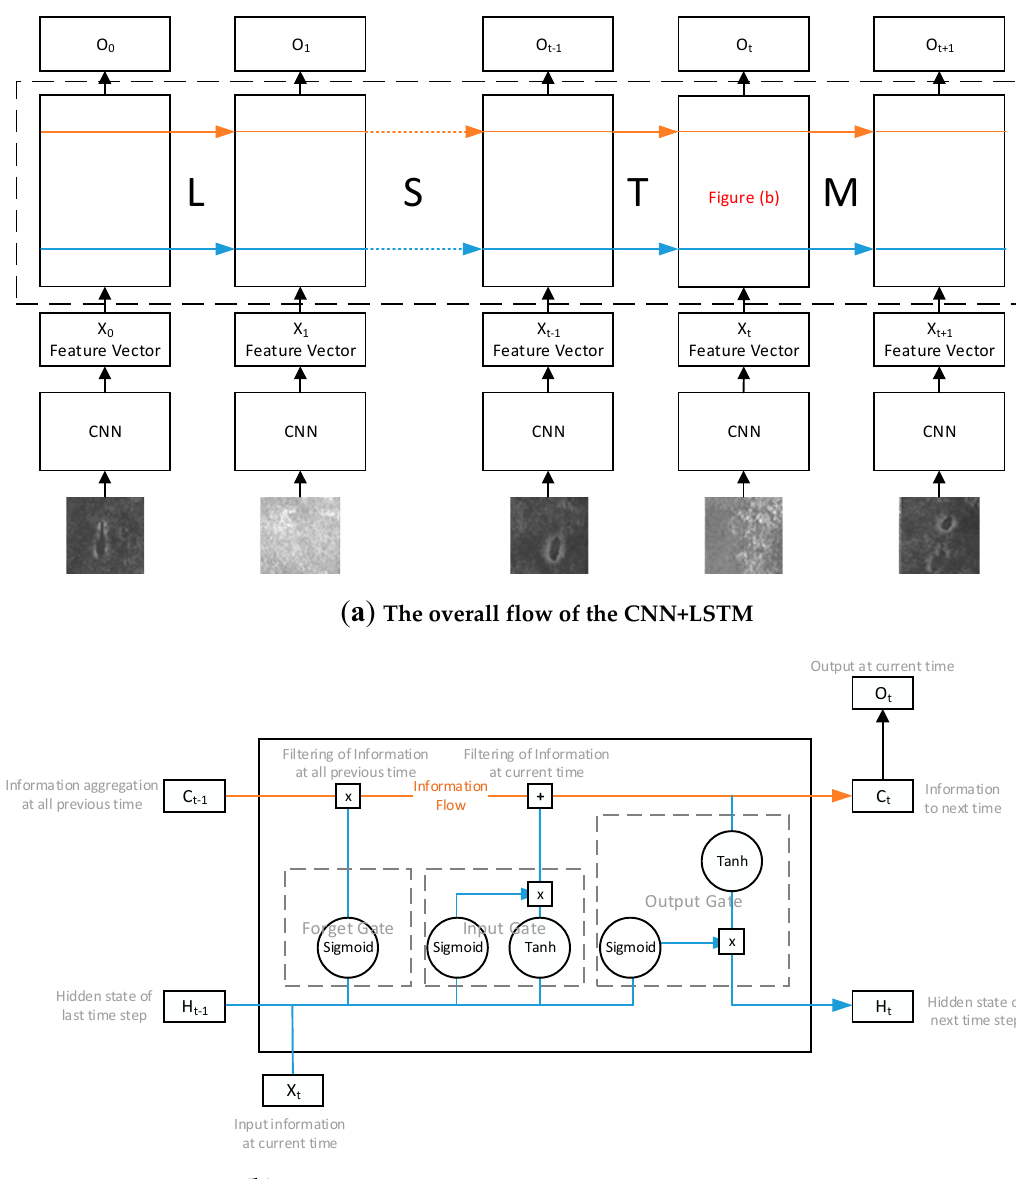
Figure 7. Flowchart of the convolutional neural network and long short-term memory (CNN + LSTM) detection method.